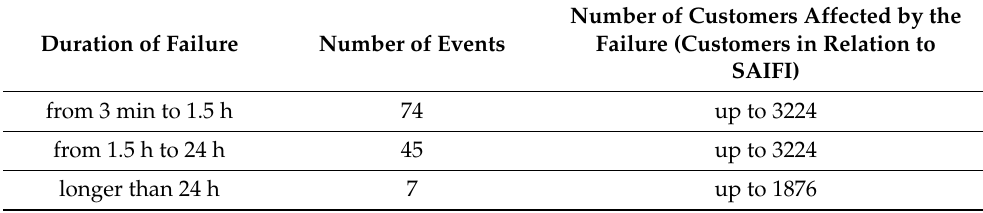
Table 2. Summary of the number of outages for the considered network that occurred in 2018.